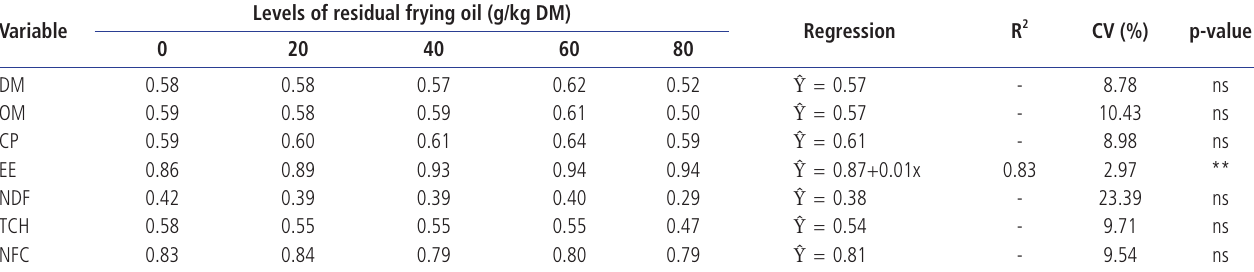
Table 3. Nutrients digestibility of diets of lambs containing different levels of residual oil frying